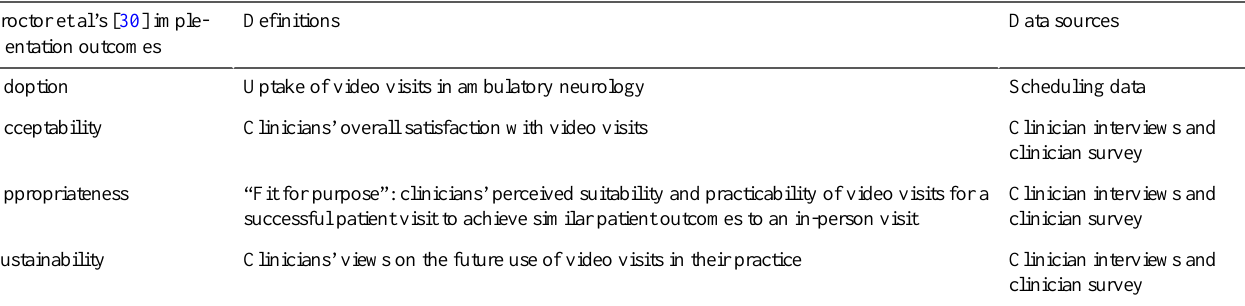
Table 1. Implementation outcomes, definitions, and data sources applied in the evaluation of the implementation of video visits in ambulatory neurology. mentation